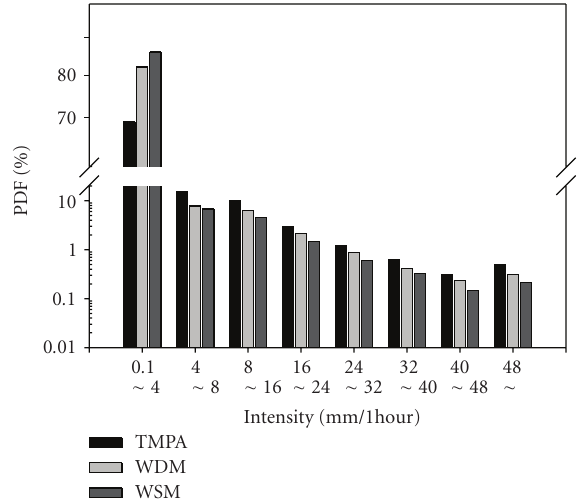
Figure 5: Probability Distribution Function (PDF) of three-hour accumulated rainfall intensity from the TMPA observations, and the corresponding results from the WDM6 and WSM6 experiments over the whole domain during the one month from 0000 UTC 1 July to 0000 UTC 1 August 2006.